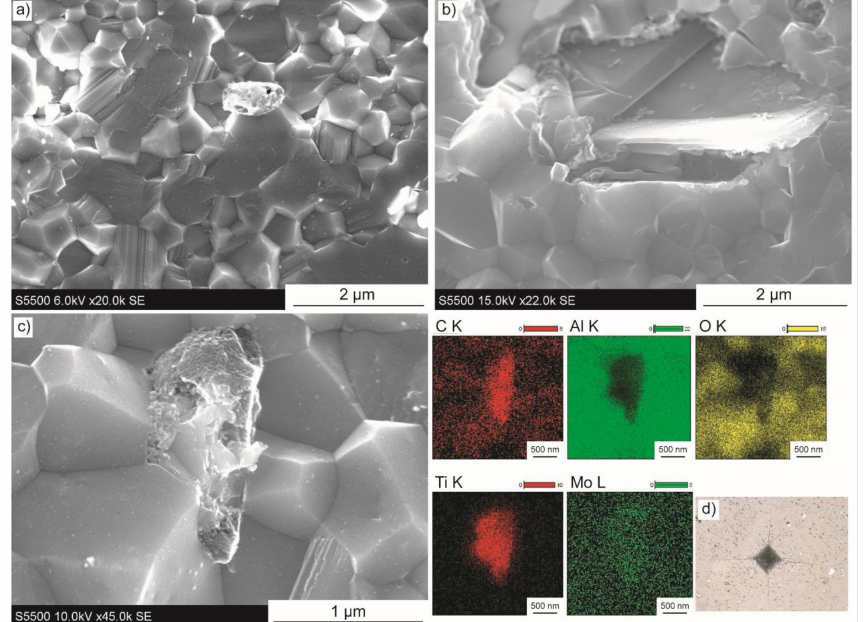
Figure 8. Microstructure images of composites with Ti 3 C 2 -Mo addition of ( a , b ) 1 wt.%, ( c ) 2 wt.% with EDS map of elements, ( d ) 0.5 wt.% with Vickers indenter imprint.